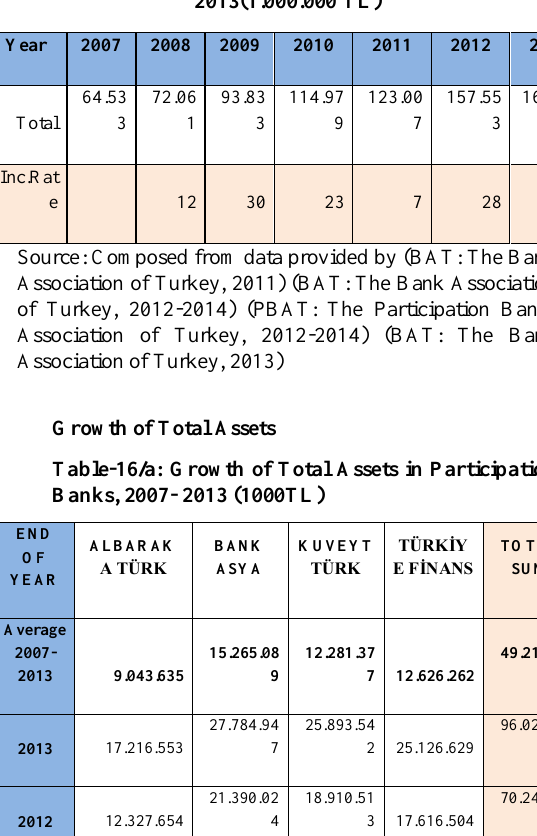
Table-15:Equity Growth of Deposit Banks,2007-